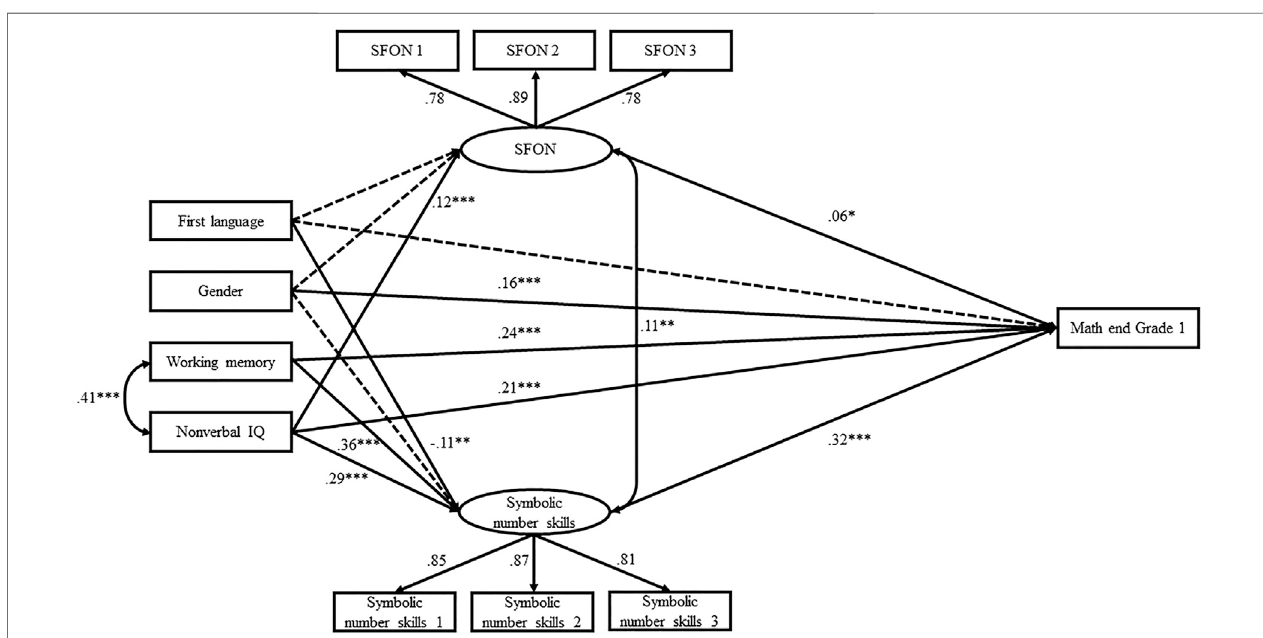
FIGURE 4 | Structural equation model of the fi nal model, containing all hypothesized paths and covariances. Solid arrows represent the hypothesized signi fi cant paths. Dashed arrows depict paths that were not signi fi cant. Standardized estimates are provided with their levels of signi fi cance. * p < 0.05, ** p < 0.01, *** p < 0.001.